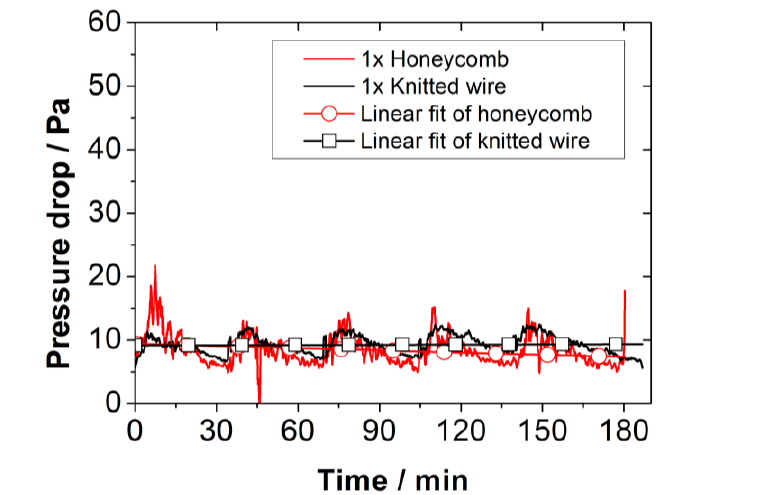
Figure 7. Signal curve and trend (linear fit) for the pressure drop across the catalyst during operation